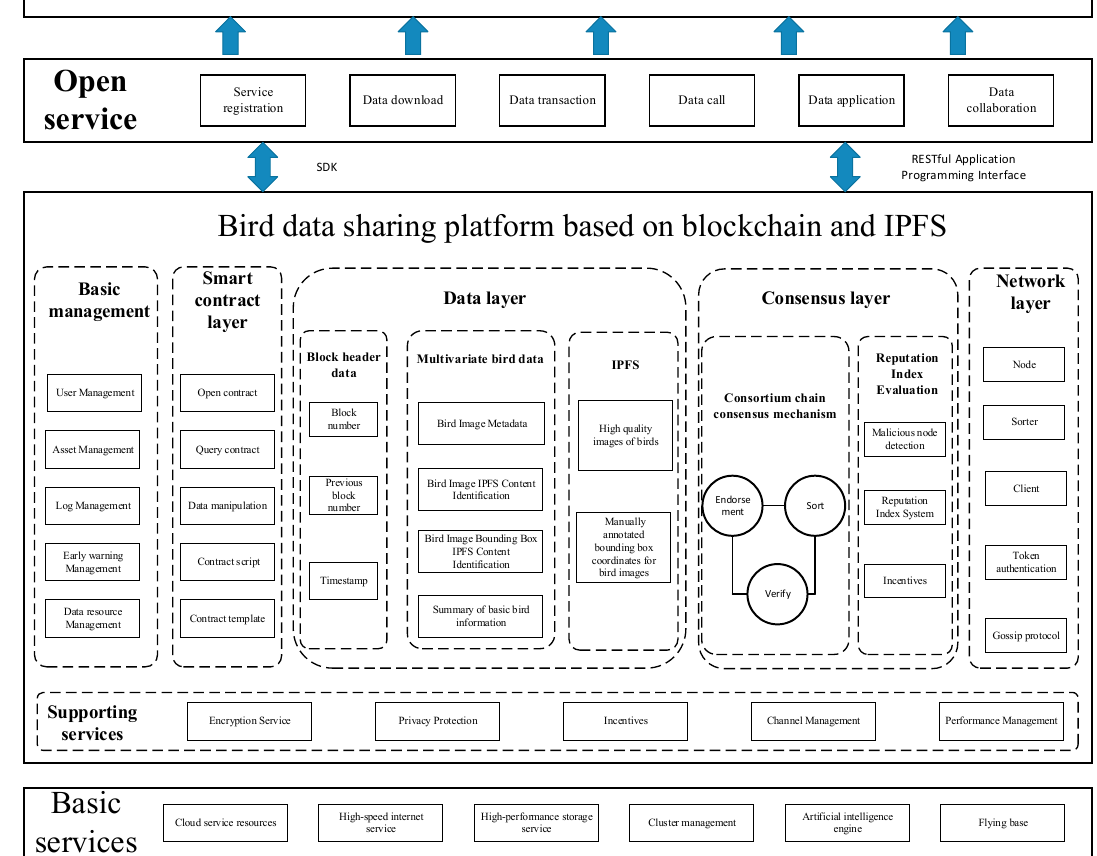
Figure 1. Blockchain-based open platform architecture for bird data.